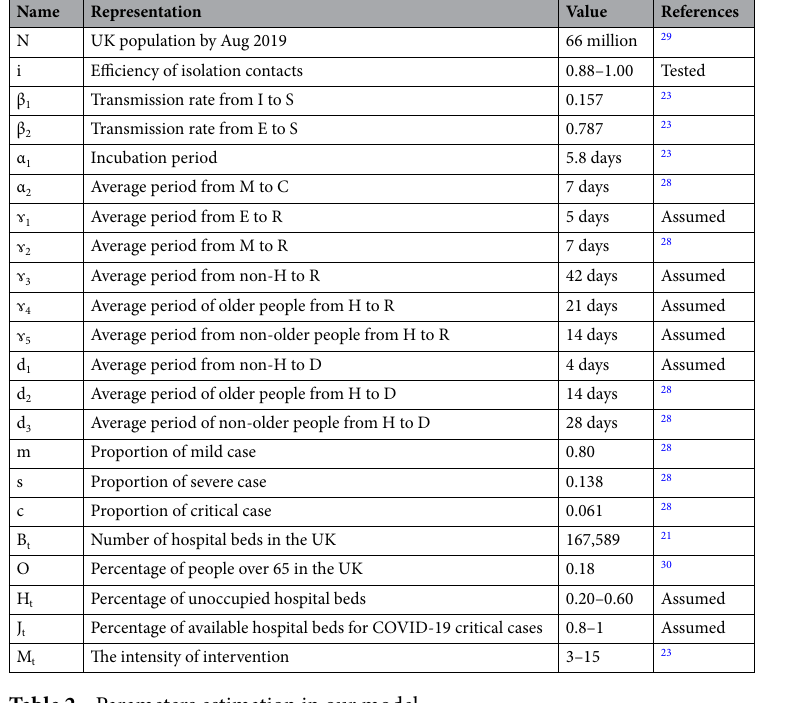
Table 2. Parameters estimation in our